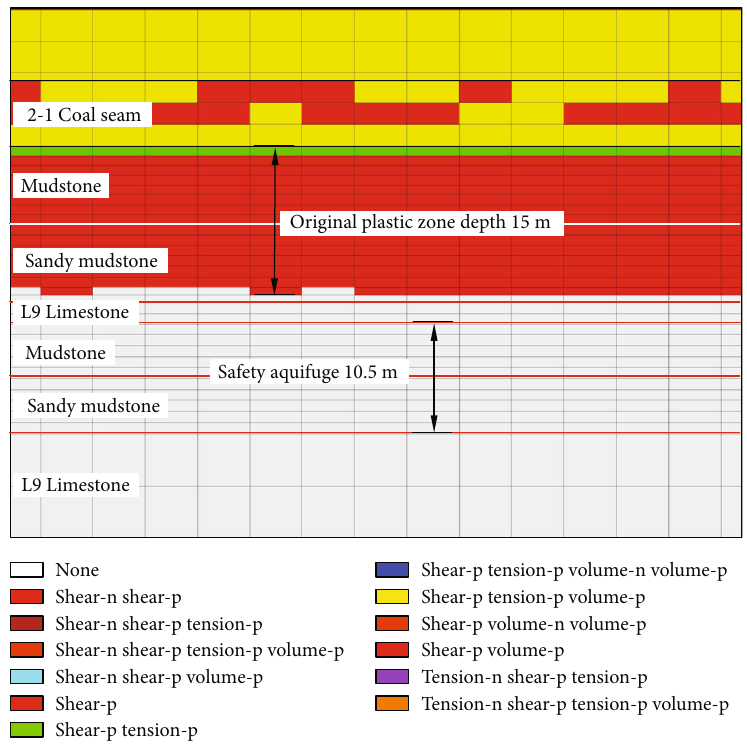
Figure 7: Failure of bottom fl oor rock stratum without fl oor drainage